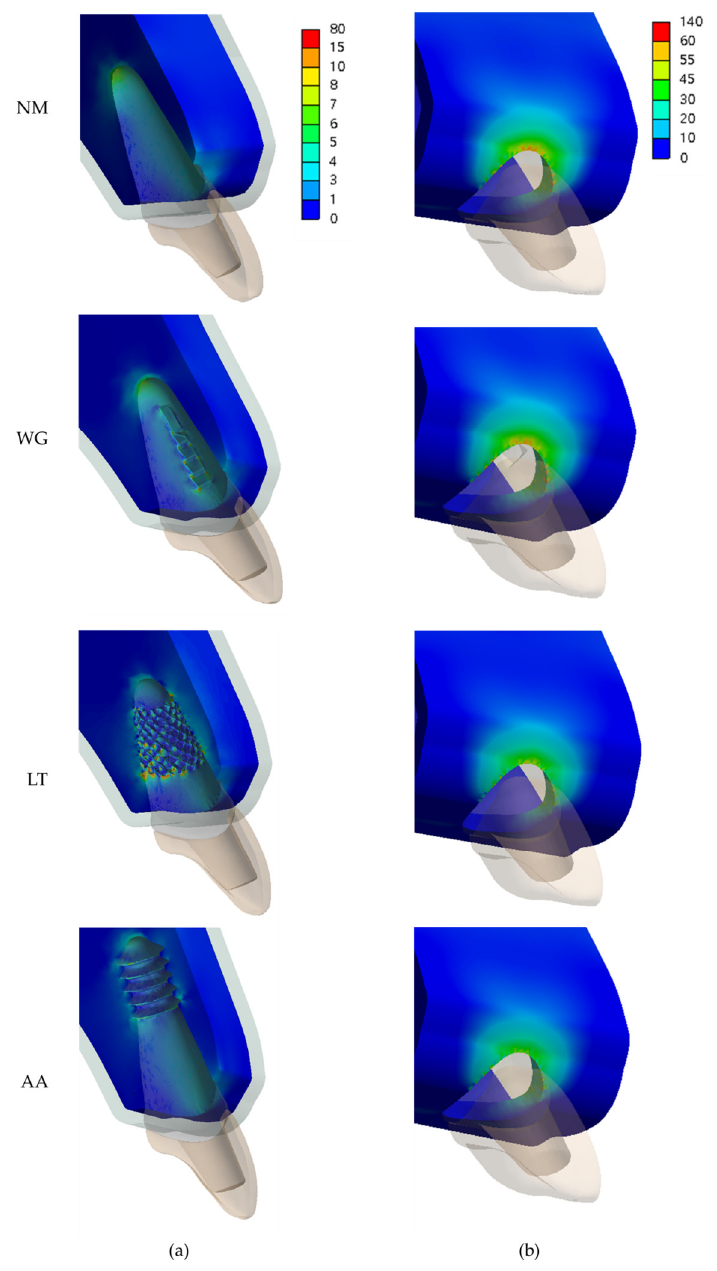
Figure 9. Maximum von Mises stress (MPa) on cancellous bone ( a ) and cortical bone ( b ) in each experimental group according to the lowest frictional coefficient values (COF = 0.1). Abbreviations: non-modified root surface (NM); wedge shape added at mesial and distal root surface (WG); lattice shape added at root surface (LT); apex-anchor added (AA).